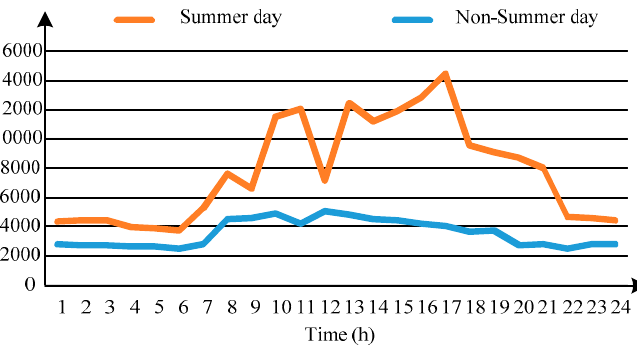
Figure 9. The operating cost of chillers on a summer day and non-summer day. The convergent characteristics of operating costs on a summer day (17 July) and a non-summer day (21 October) are as given in Figure 10. Using ACO to optimize the energy planning for the ice-storage air-conditioning system can effectively reduce costs. The electricity savings are thus 4.130% on a summer day and 7.381% on a non-summer day. This system can also yield a better plan for ice storage and melting procedures.